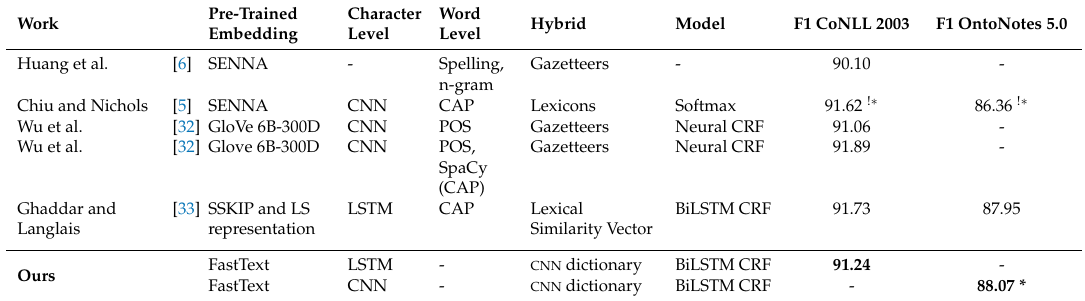
Table 9. The comparison of our model with the previous similar dictionary-enabled works.